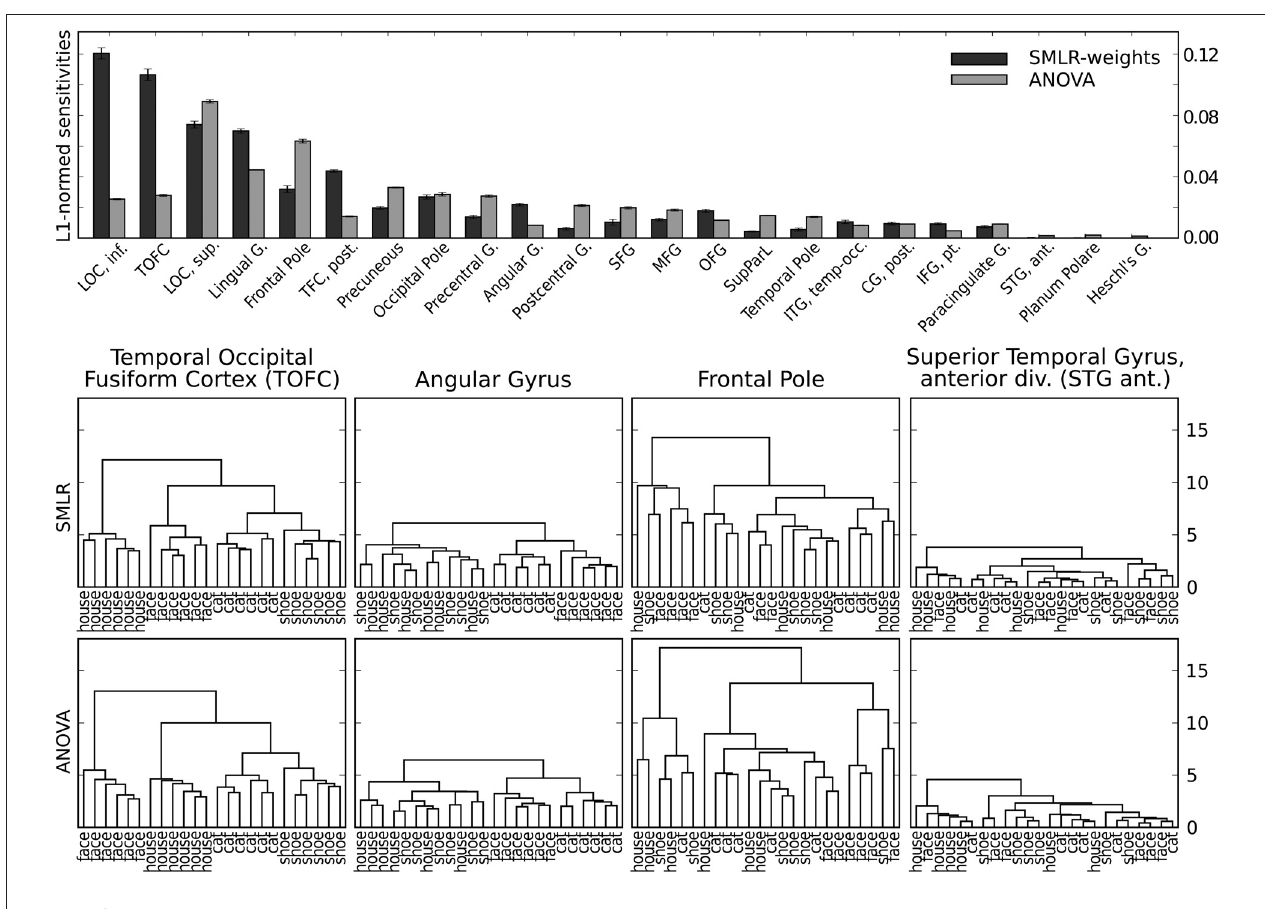
FIGURE 4 | Sensitivity analysis of the four-category fMRI dataset. The upper part shows the ROI-wise scores computed from SMLR classifi er weights and ANOVA F -scores (limited to the 20 highest and the three lowest-scoring ROIs).